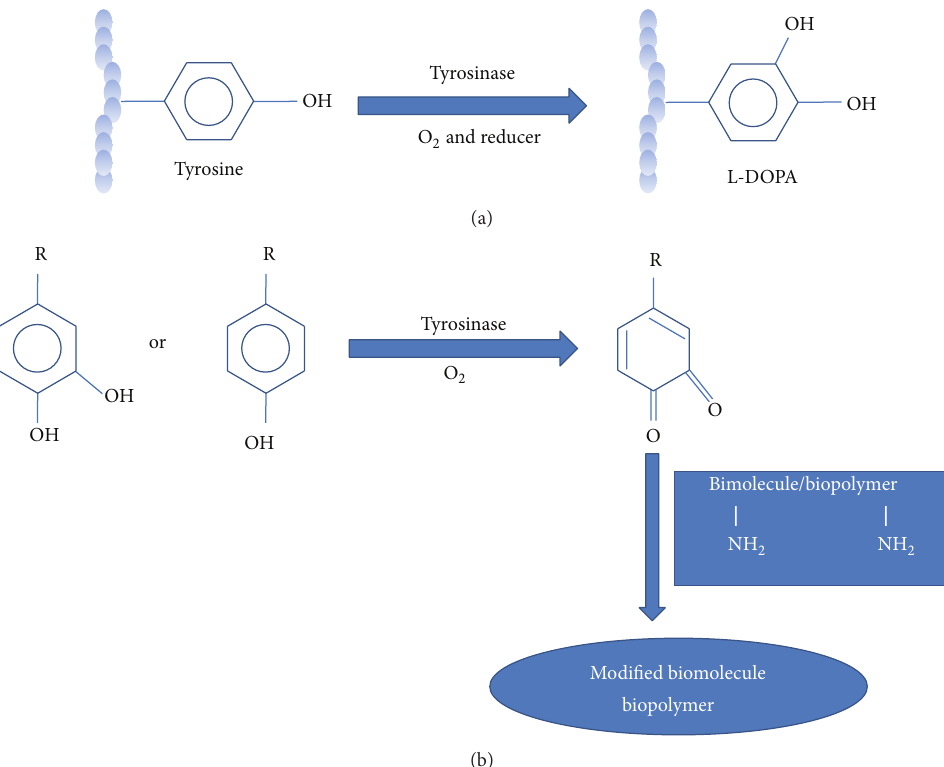
Figure 7: Transfer of tyrosine amino acids into DOPA by the action of tyrosinase in the presence of a reducer. (a) Oxidation of phenol or catechol derivatives into reactive o -quinones using tyrosinase, followed by the grafting of amino-functionalized biomolecules/biopolymer